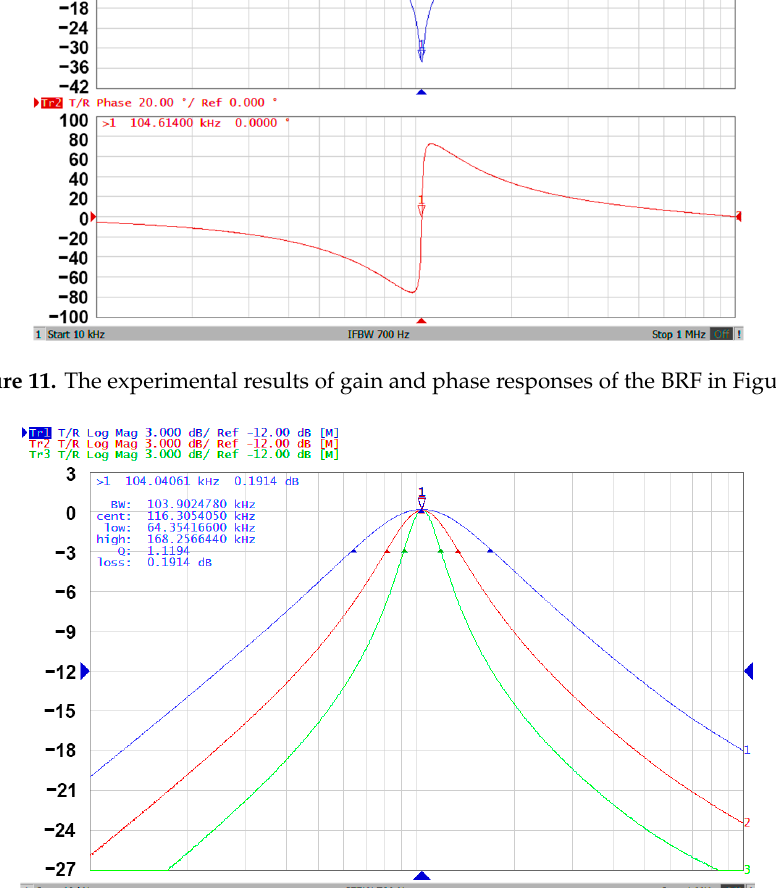
Figure 12. The experimental results of gain responses by varying Q while keeping f o (Q = 1.12—blue line; Q = 2.04—red line; and Q = 3.91—green line). Sensors 2020 , 20 , x FOR PEER REVIEW